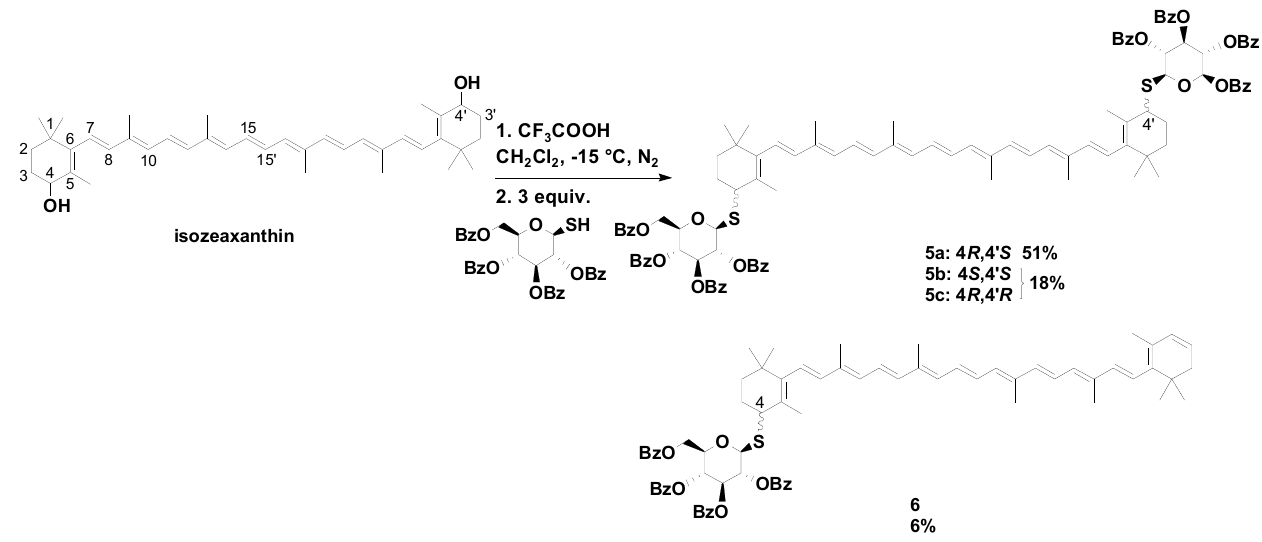
Scheme 1. Synthesis of thermoxanthin mimetics.